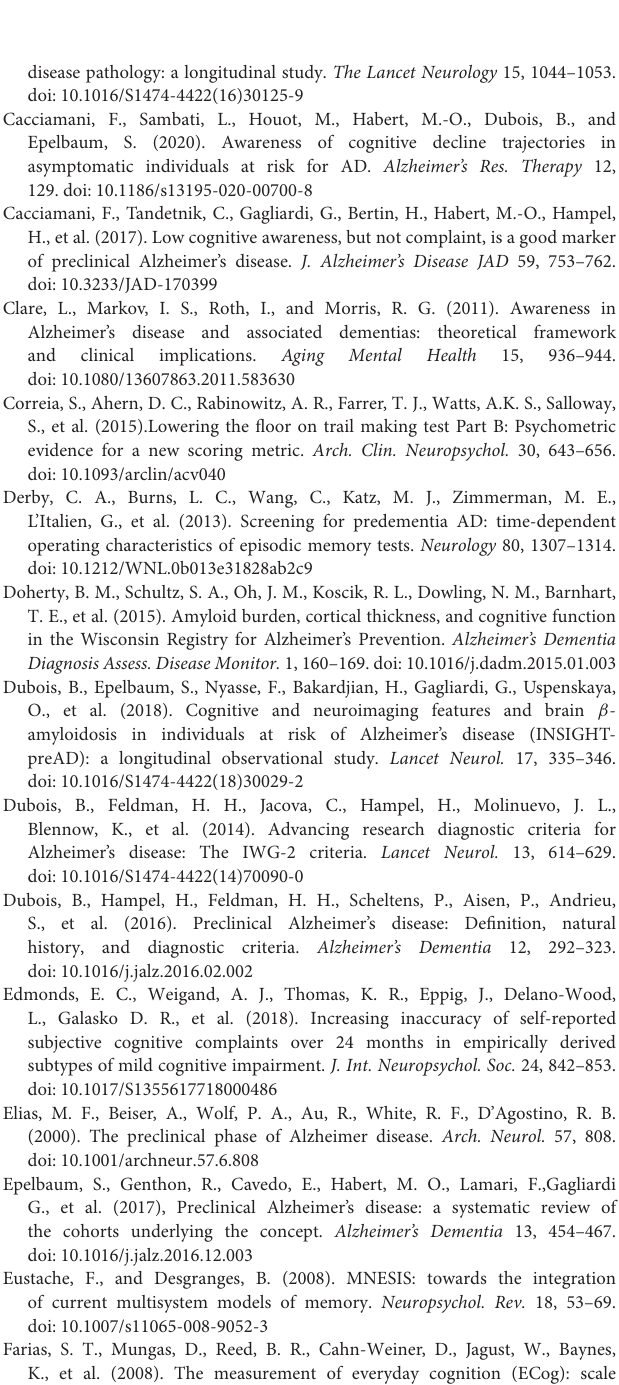
Supplementary Table 1 | Relationship between executive function measure and awareness. Supplementary Table 2 | Relationship between episodic memory measure and awareness. Supplementary Table 3 | Relationship between amyloid measure and awareness. Supplementary Table 4 | Number of participants extracted from ADNI cohorts.